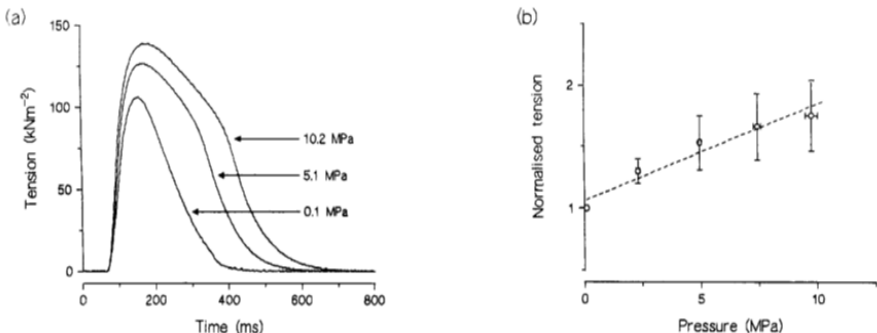
Figure 11. Effects of high pressure on isometric twitch contractions of a single fibre at 4 °C. ( a ) Sample records at three pressures, ( b ) pooled data from four fibres (from Vawda, Geeves, and Ranatunga, [7]).